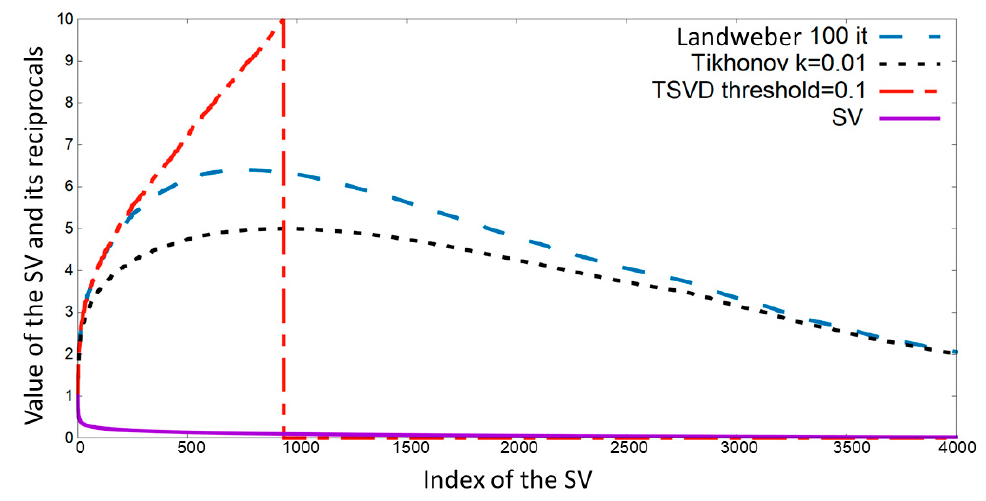
Figure 2. Singular values of a small matrix (solid line) and its reciprocals using different regularization methods. Tikhonov ( k = 0.01) and Landweber ( n = 100) regularization for equivalent iterations. Truncated singular values (TSVD) with a threshold of 0.1 and original singular values (SV) are also shown.